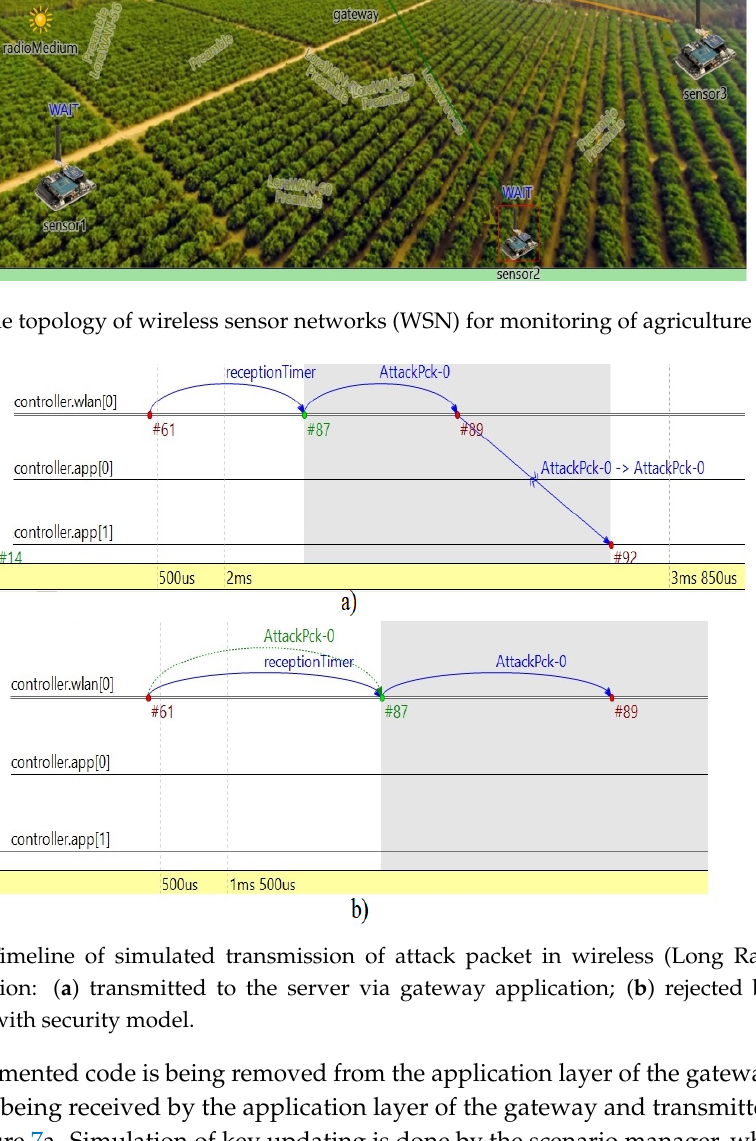
Table 2. LoRa SX1272 characteristics. Transmission Power (dBm)